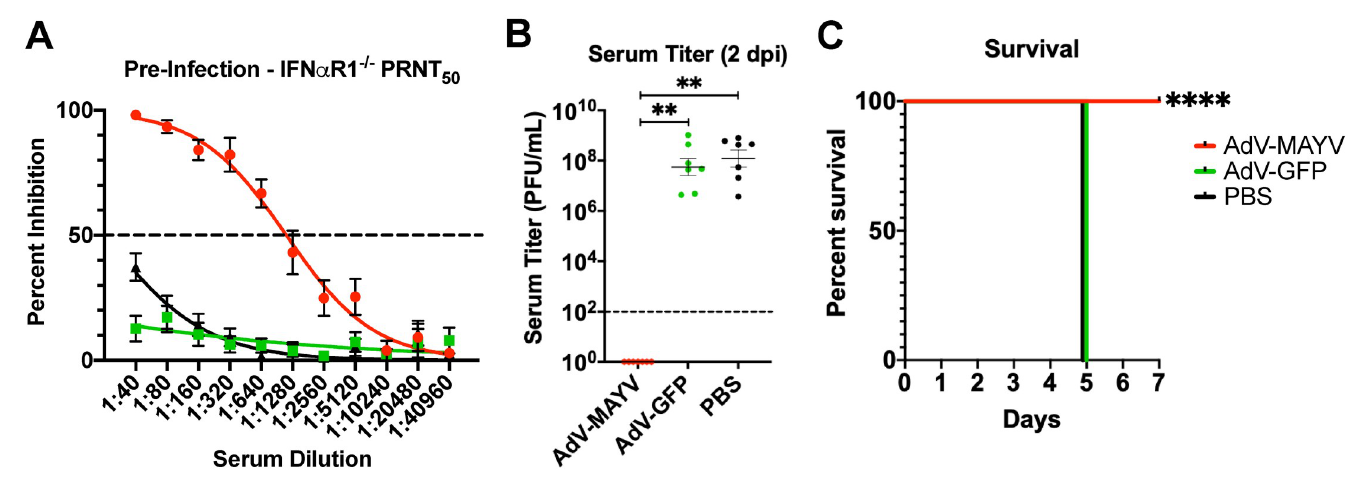
Fig 7. AdV-MAYV Vaccination Protects IFN α R1 -/- Mice from Lethal Challenge. Male and female IFN α R1 -/- mice were vaccinated with 10 8 PFU AdV-MAYV, AdV-GFP, or PBS by i.m. injection followed by a booster vaccination 14 days later. At day 28, mice were challenged with 1x10 4 PFU/ml MAYV BeAr in the right footpad. The data presented represents one independent experiment (n = 7 mice per vaccine). (A) Prior to challenge, blood was collected to measure neutralizing titers against MAYV CH by PRNT assay. AdV-MAYV elicited robust neutralizing antibodies in IFN α R1 -/- mice. Error bars represent SEM. (B) Limiting dilution plaque assays were used to measure viremia for blood serum samples collected at 2 dpi. Black dotted line indicates limit of detection (100 PFU/ml). Statistical analysis was performed on log- transformed data using a Kruskal-Wallis test ( �� P < 0.005). Error bars represent SD. (C) Mouse morbidity and mortality was monitored daily for 7 days post infection with Kaplan-Meier survival curve analysis ( ���� P <